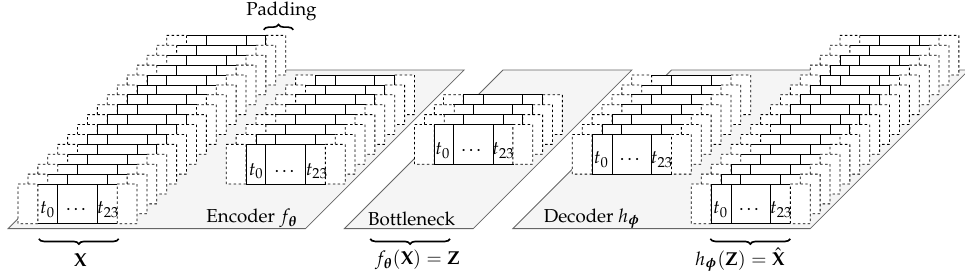
Figure 3. An example undercomplete time series AE topology. The AE reduces the dimensionality in each layer of the encoder. The latent features’ representation at the bottleneck are the extracted hidden features sufficient to reconstruct the original input successively in each layer of the decoder.